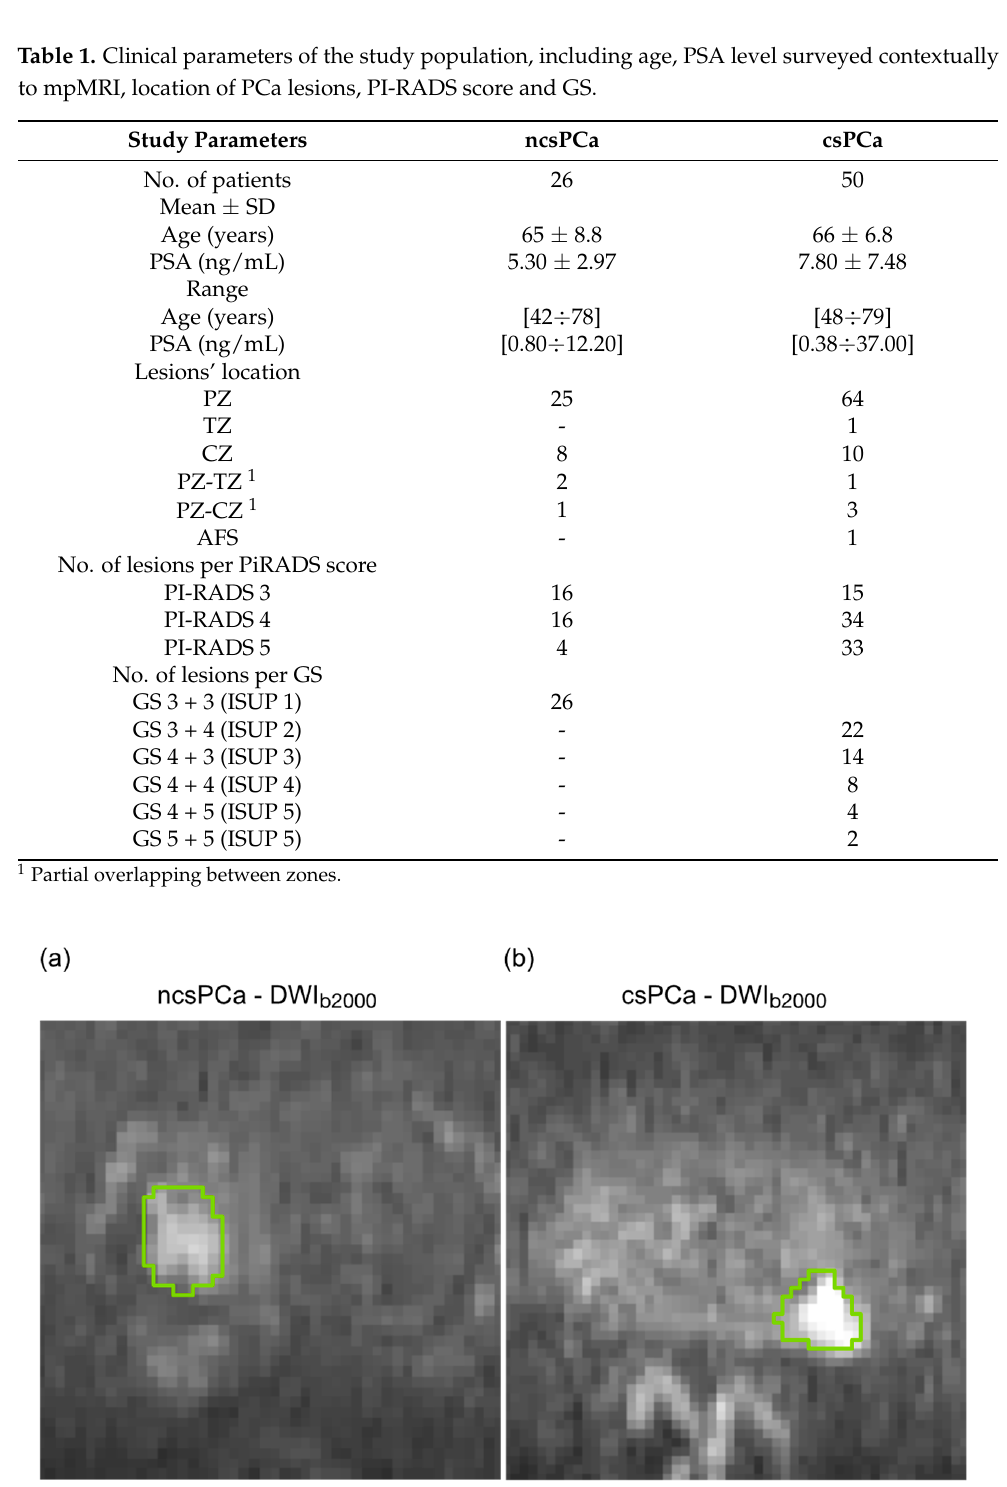
Figure 1. ( a ) ROIs of PCa lesions outlined on DWI b2000 for a representative ncsPCa; ( b ) ROIs of PCa lesions outlined on DWI b2000 for a representative ncsPCa. lesions outlined on DWI b2000 for a representative